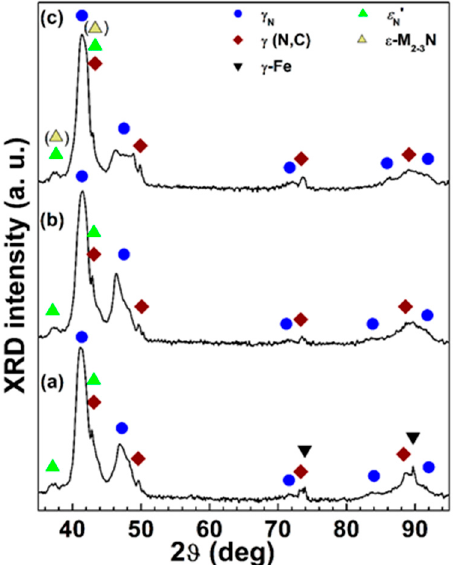
Figure 4. X-ray diffraction patterns of samples nitrided at 360 °C, with 50 vol.% N 2 + 50 vol.% H 2 , for 1 ( a ), 3 ( b ), and 5 ( c ) h. for 1 ( a ), 3 ( b ), and 5 ( c )